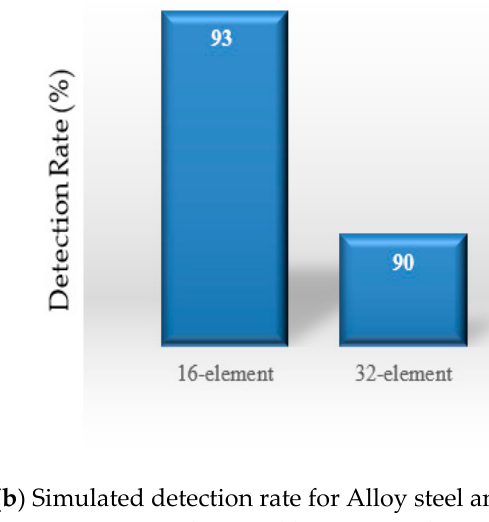
Figure 11. CIVA Simulation Configuration.